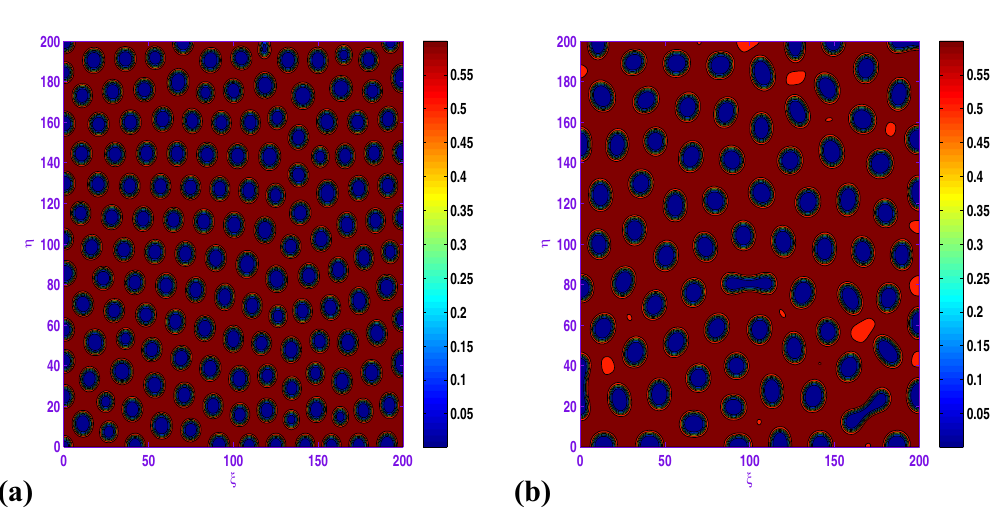
Figure 9. Transition of spatial dynamics of the prey population (9) at t = 5000 , for the set a = 0.5 , b = 0.9 , β = 1.05 , d = 0.3 , d 1 = 0.1 , d 2 = 20.0 and ( a ) l = − 0.01 ; ( b ) l = − 0.04